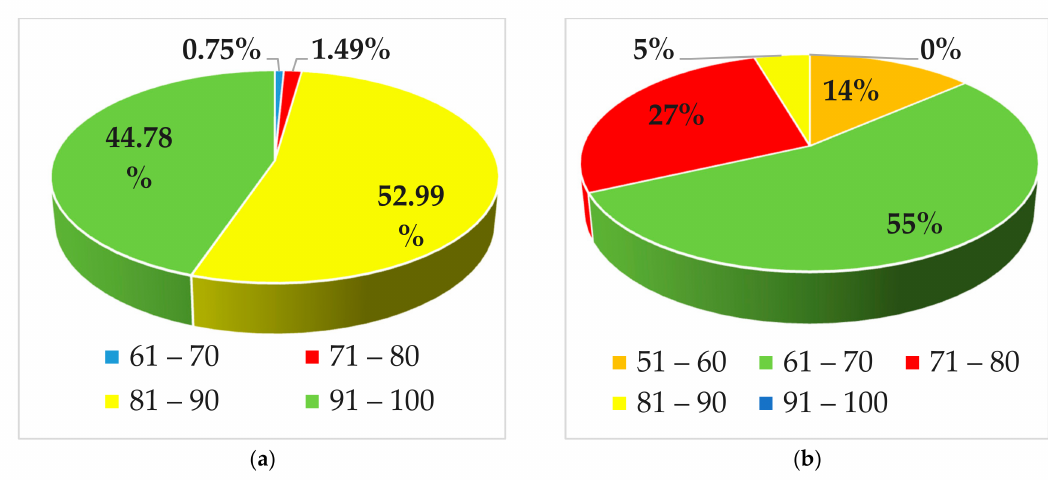
Figure 3. The level of consumer trust in WoM ( a ) and digital media ( b ).